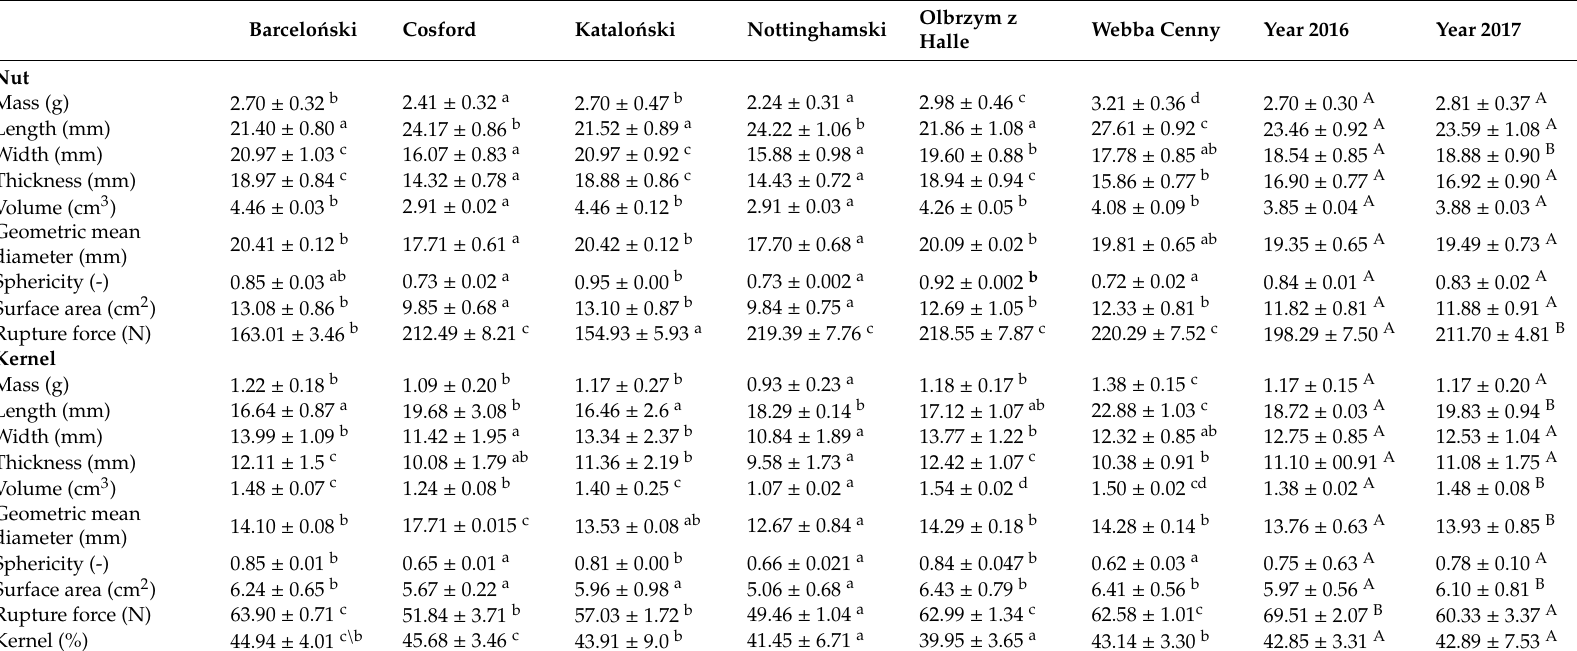
Table 2. Physical properties and geometric measurements of nuts and kernels ( n =